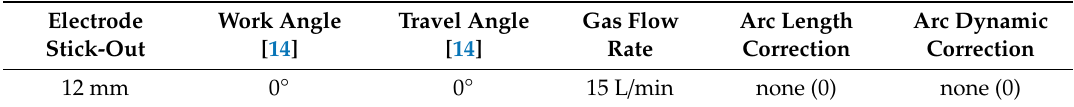
Table 3. Parameters that were kept constant.